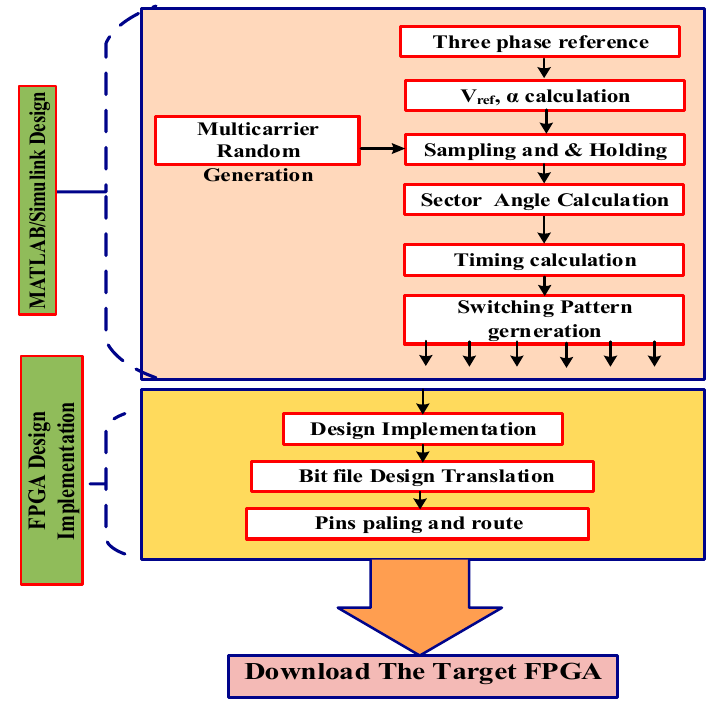
Figure 10. Design flow of FPGA implementation on MCRSVPWM.